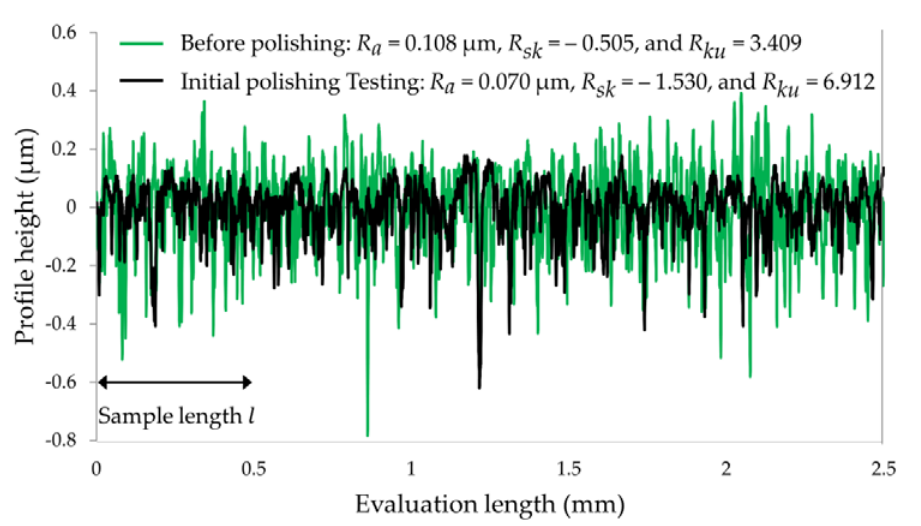
Figure 4. Roughness height profile of the surface of the watch bezel.